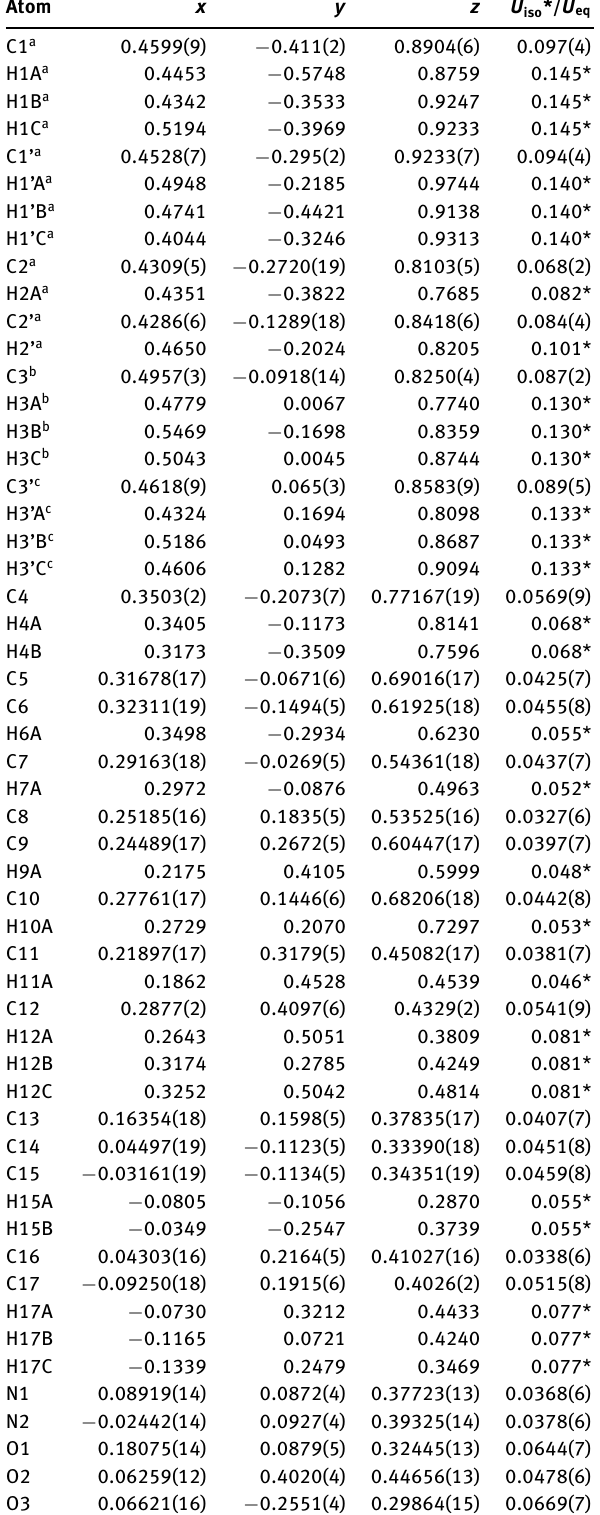
Table 2: Fractional atomic coordinates and isotropic or equivalent isotropic displacement parameters (Å 2 ).